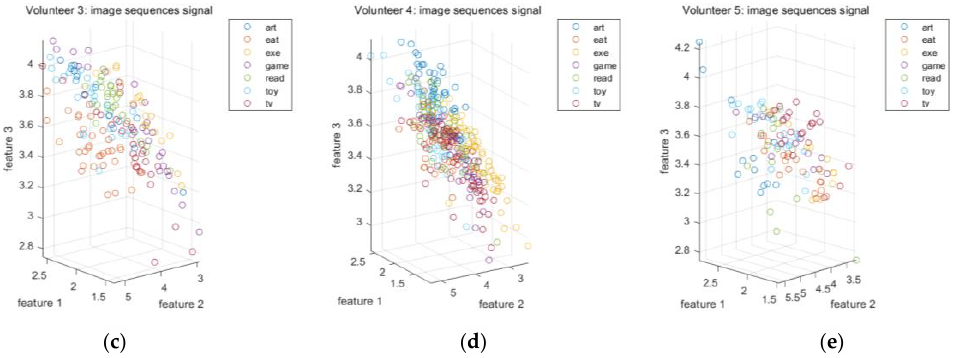
Figure 5. ( a ) Some of the features extracted from the image sequences when the first volunteer performs various activities. ( b ) Some of the features extracted from the image sequences when the second volunteer performs various activities. ( c ) Some of the features extracted from the image sequences when the third volunteer performs various activities. ( d ) Some of the features extracted from the image sequences when the fourth volunteer performs various activities. ( e ) Some of the features extracted from the image sequences when the fifth volunteer performs various activities.